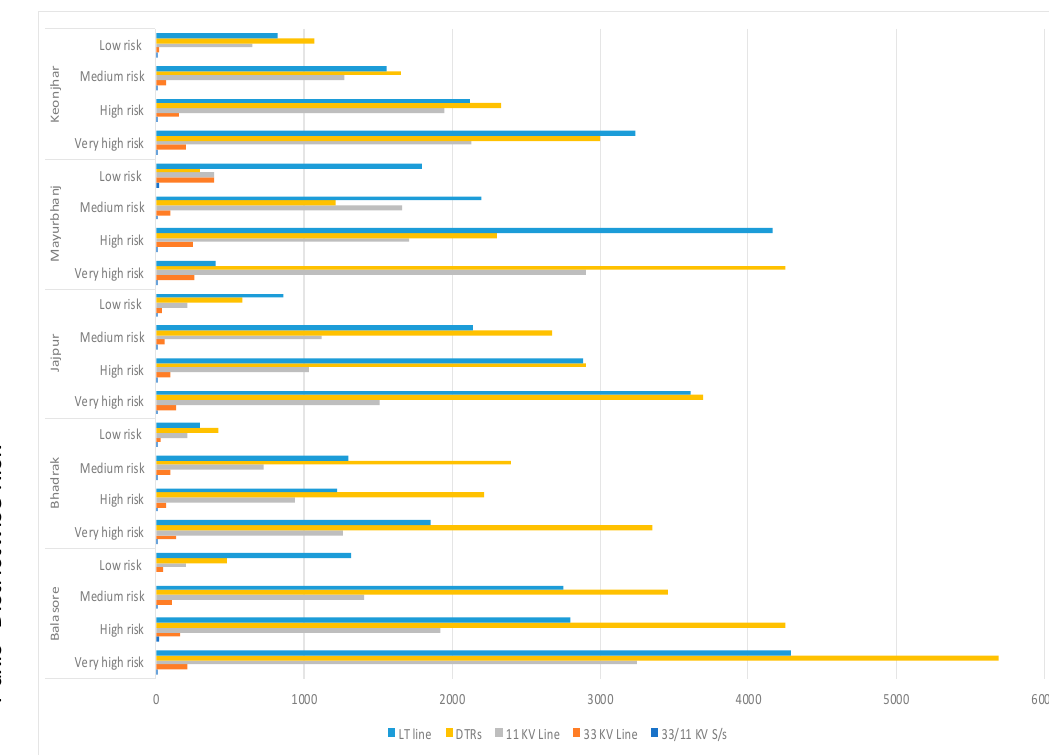
Figure 3. Cyclone risk map of power lines in five districts of Odisha, Source: [42]